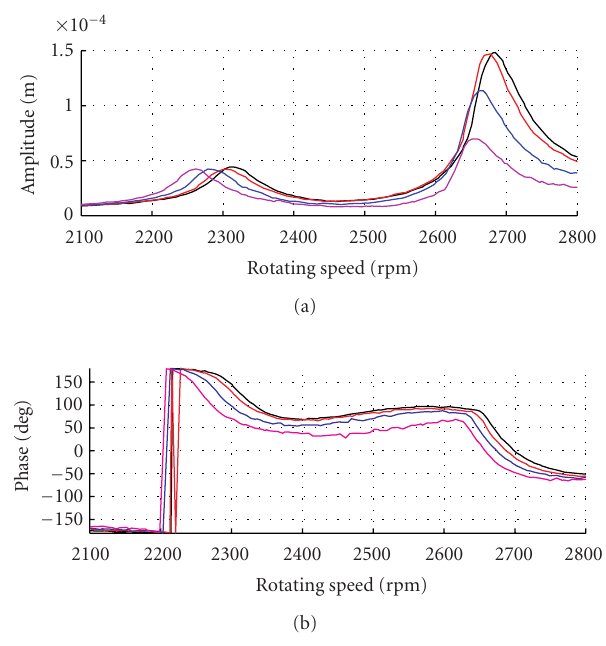
Figure 18: Unbalance responses of the 1st order for various bearing temperatures at the bearing support B1 (black line = 25 ◦ C; red line = 35 ◦ C; blue line = 40 ◦ C; magenta line = 48 ◦ C).